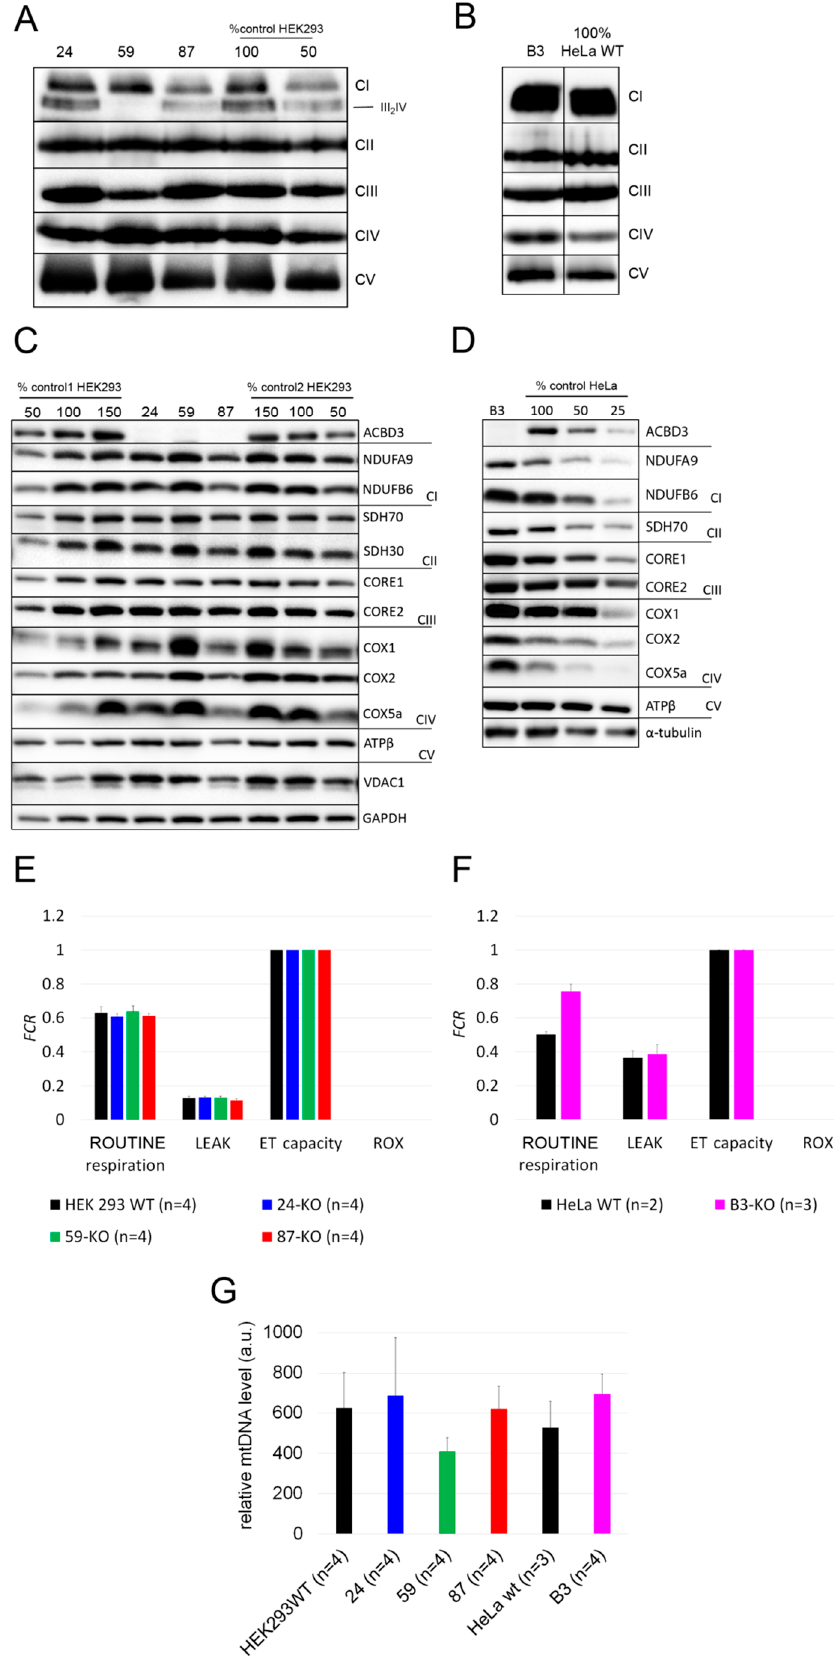
Figure 4. Mitochondrial investigations in ACBD3-KO cells. ( A ) Steady-state level of OXPHOS protein complexes in iso- lated mitochondria from HEK293 and ( B ) HeLa analyzed by BN-PAGE/WB. The numbers 50 and 100 show the loading